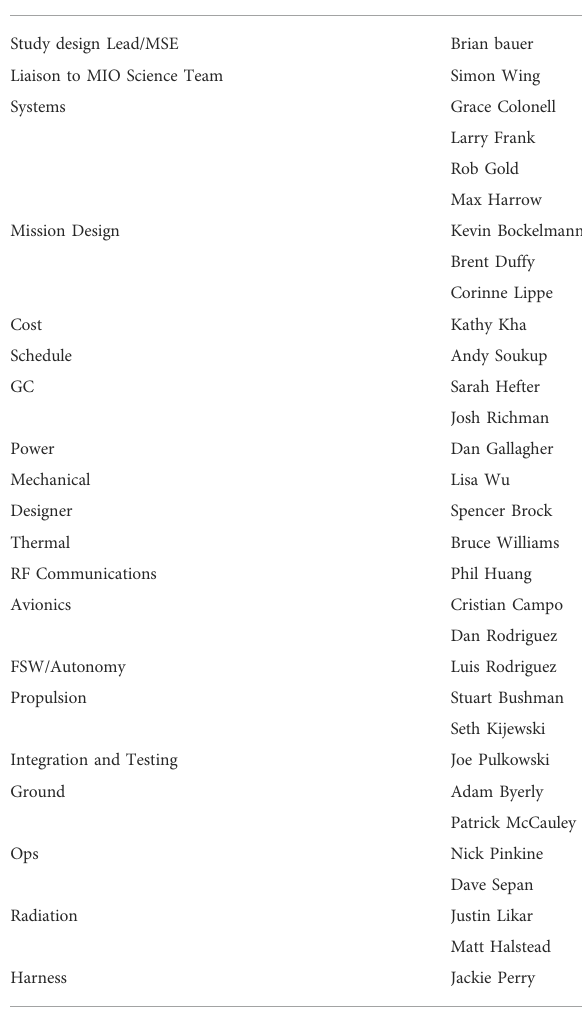
TABLE 2 The MIO HMCS engineering team at the applied physics